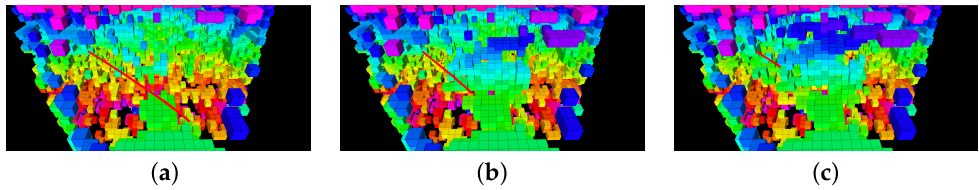
Figure 17. Hardware flight testing: successive captures of screen ( a – c ) displaying sensed environment (blocks) and planned path (red line) of